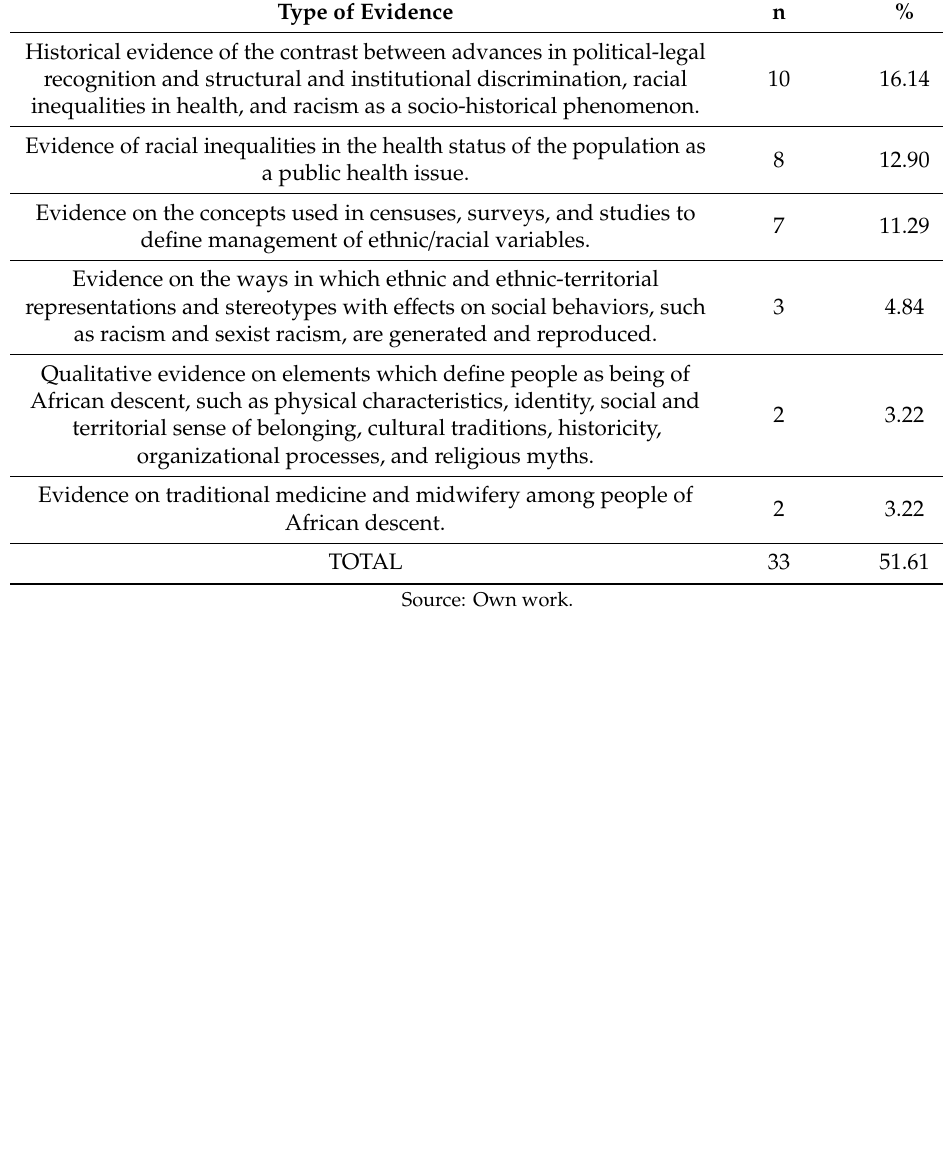
Table 6. Quantitative studies included in this review, stratified by type of evidence provided. Box: Number and percentage of qualitative studies identified Type of Evidence n